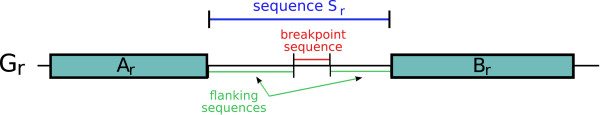
Schematic representation of a breakpoint and its flanking sequences. The original breakpoint (before refinement) lies between synteny blocks Ar and Br on genome Gr, its sequence is called Sr. The breakpoint sequence after refinement, is represented in red. The flanking sequences (showed in green) are defined as the sequences of sequence Sr that are not part of the breakpoint region. We consider in this analysis breakpoints whose sequence (in red) spans more than 10 Kb, and for which at least one flanking sequence spans more than 10 Kb.